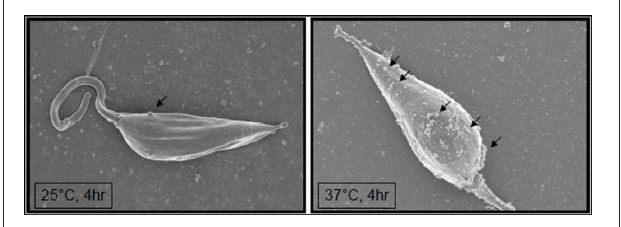
FIGURE 2 | Temperature shift (25–37 ◦ C) induces formation of exosomes at the surface of Leishmania mexicana promastigotes. (Arrows point at emerging exosomes). Hassani and